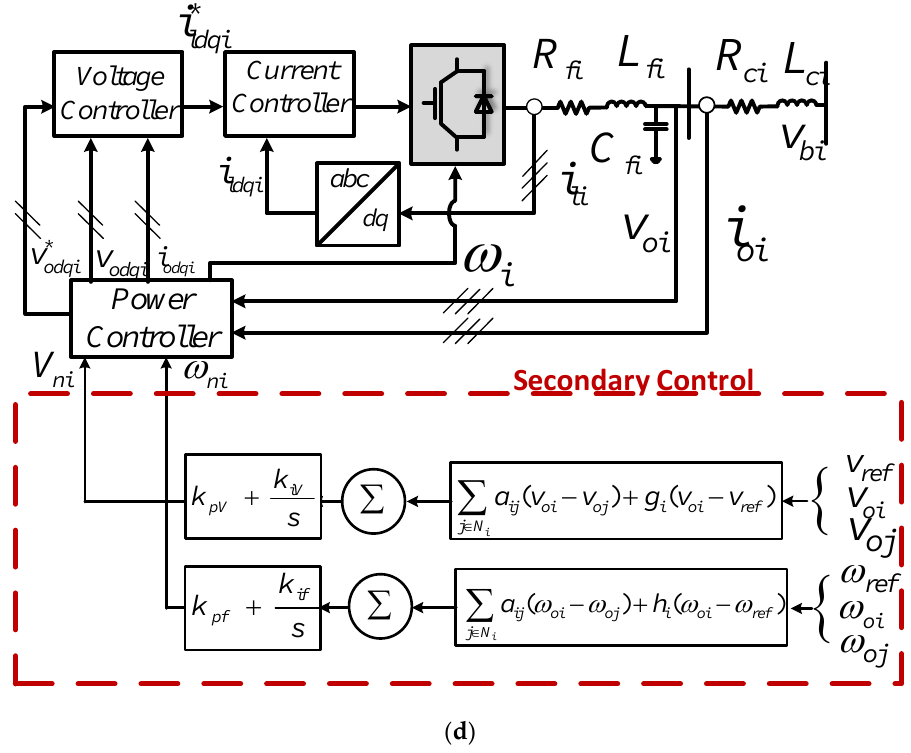
Figure 2. ( a ) Voltage Control loop; ( b ) Current Control loop; ( c ) Primary Control: Power Controller; ( d ) Secondary Control: Voltage and Frequency regulation.